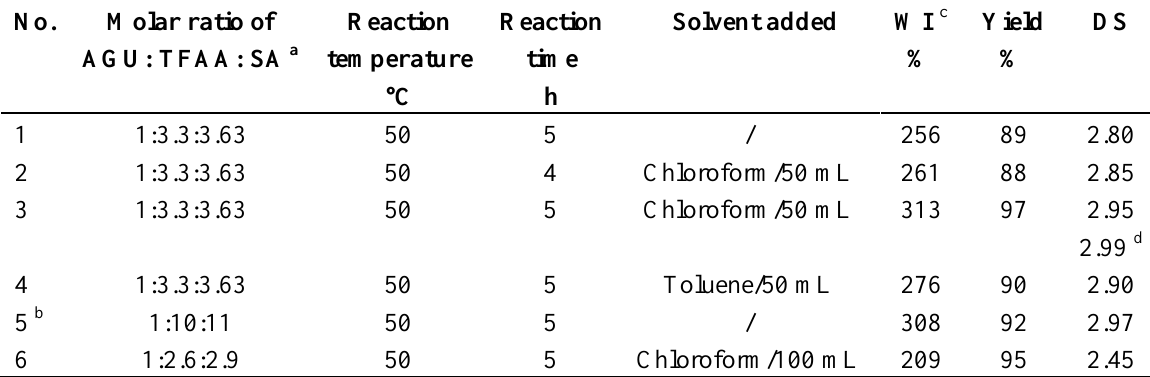
Table 1. Reaction conditions and degree of substitution (DS) of cellulose stearate.